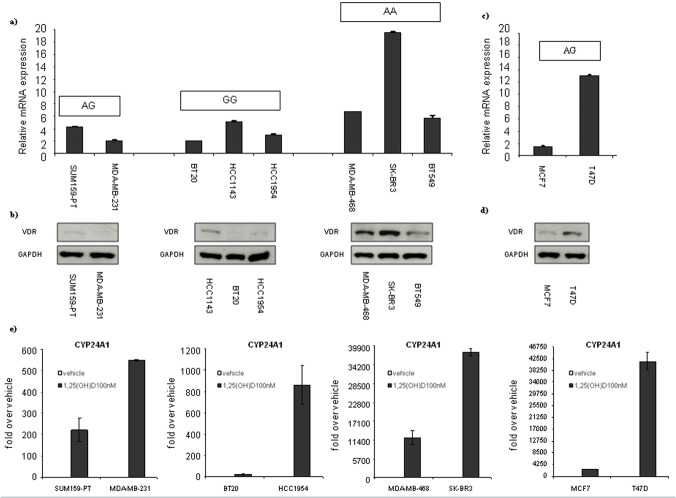
VDR transcript and protein basal levels.(a, c) Q-PCR for the expression of VDR gene from a panel of breast cancer cell lines. (b, d) Representative western blot analysis of whole cell lysates obtained from breast cancer cell lines stained with the indicated antibodies. GAPDH staining was used as a loading control. Cells were separated based on their Cdx2 status. (e) Q-PCR for the expression of CYP24A1 gene from eight representative breast cancer cell lines treated or not with 100 nM of 1,25(OH)2D3 for 24 hours.